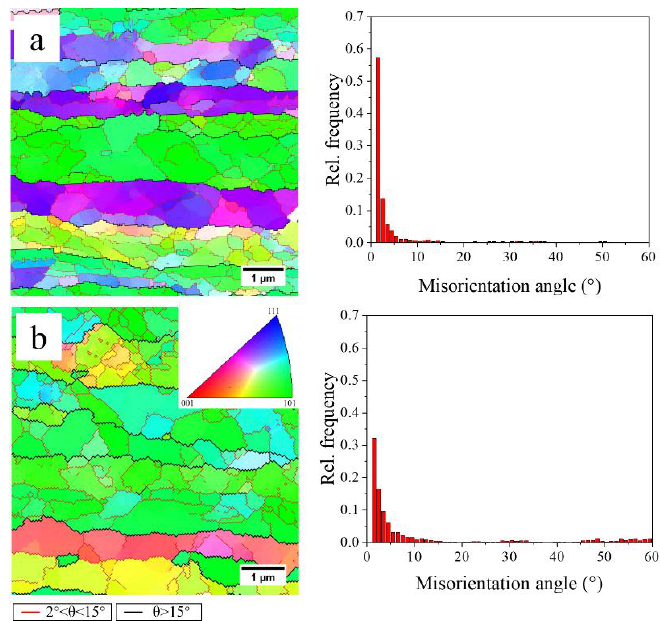
Figure 9. The EBSD maps and corresponding histograms of the misorientation angle distribution of samples quenched at 300 °C ( a ) FH, ( b ) SH.